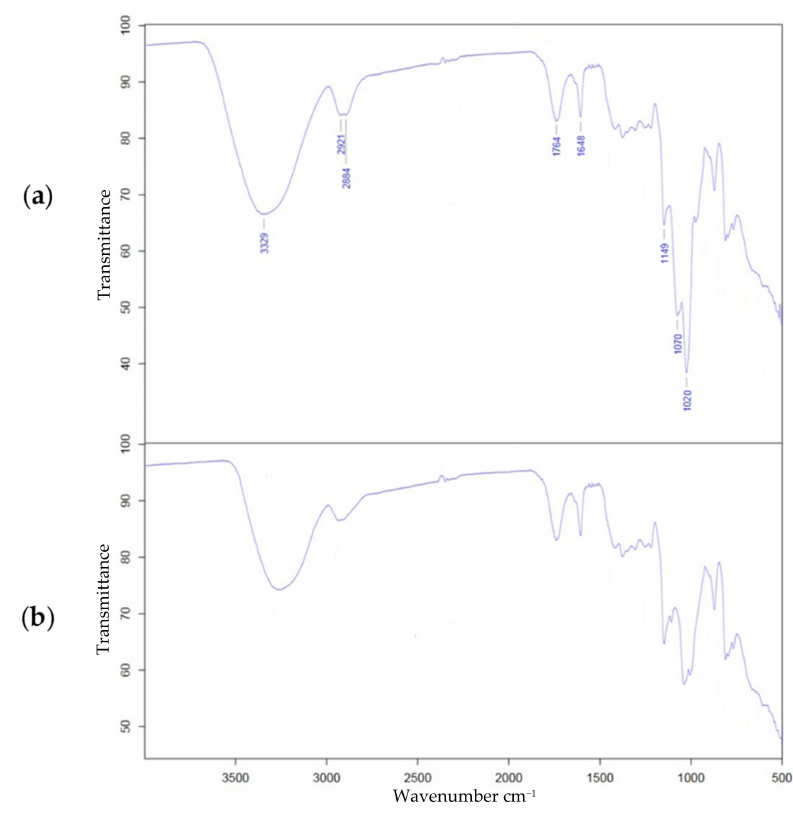
Figure 2. Typical FTIR-ATR spectra of alkylated ( a ) and native ( b ) pectin.